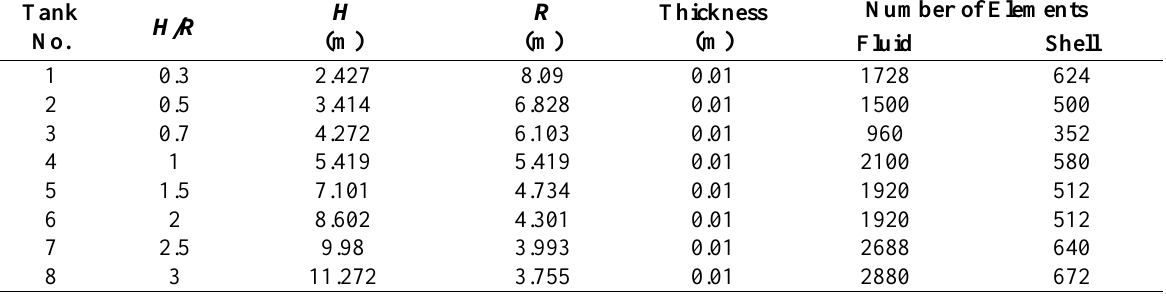
Table 4. Characteristics of the selected tanks